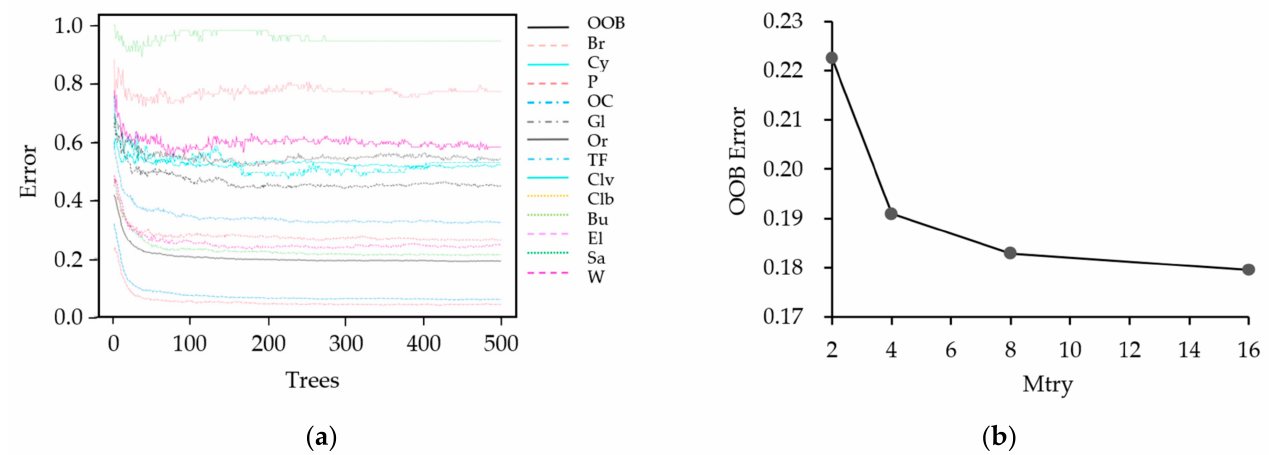
Figure 10. The trend of error rate changes in the process of generating entire RF model: ( a ) class-based and OOB error rate before tuning; and ( b ) the OOB error rate reduction achieved by tuning